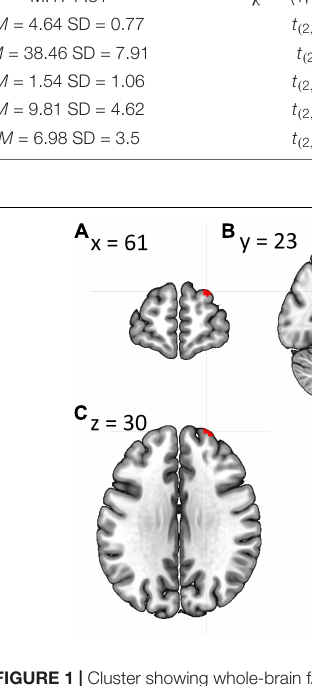
FIGURE 1 | Cluster showing whole-brain fALFF analysis differences between both groups in (A) coronal plane, (B) sagittal plane, and (C) axial plane. The template “Ch2bet” was obtained from MRIcroGL.